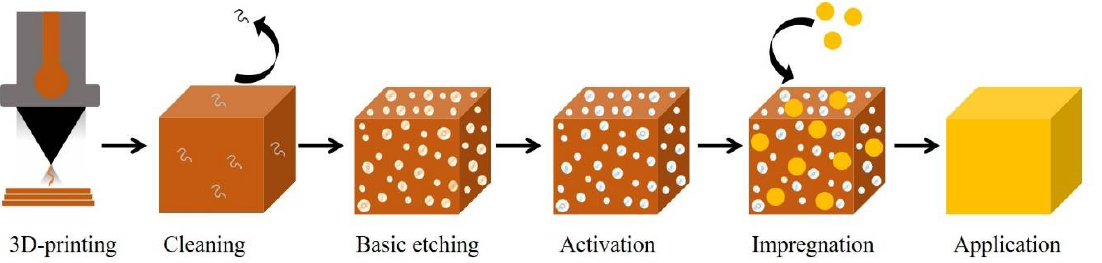
Figure 1. Printing, etching, and impregnation of 3D-printed samples developed in this work.